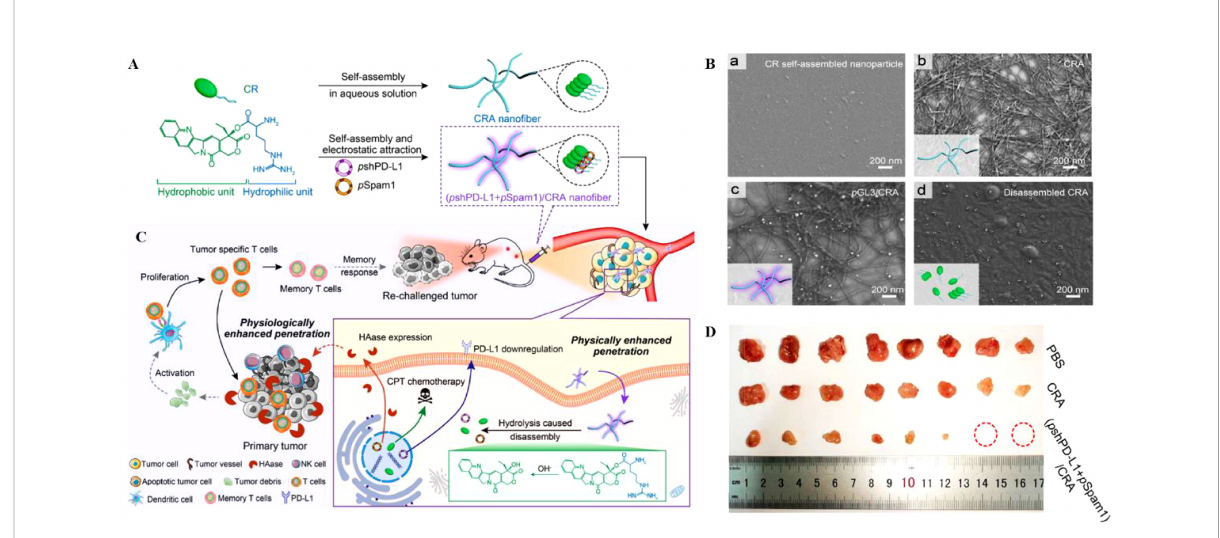
FIGURE 1 (A, B) . Schematic diagram of (pshPD-L1+pSpam1)/CRA self-assembly (Scale Bar = 200nm). (C) Schematic diagram of (pshPD-L1+pSpam1)/CRA for tumor immunotherapy. (D) Tumor size of 4T1 tumor-bearing mice treated with PBS, CRA and (pshPD-L1+pSpam1)/CRA, respectively (31). Reprinted with permission from Ref. (31). Copyright© 2021, copyright Guo et